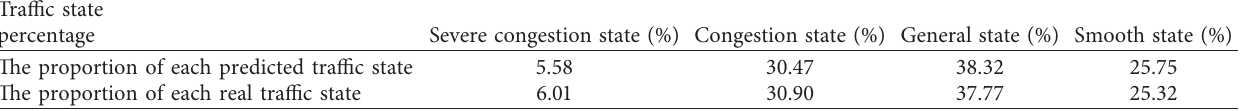
Table 3: The proportion of each traffic state